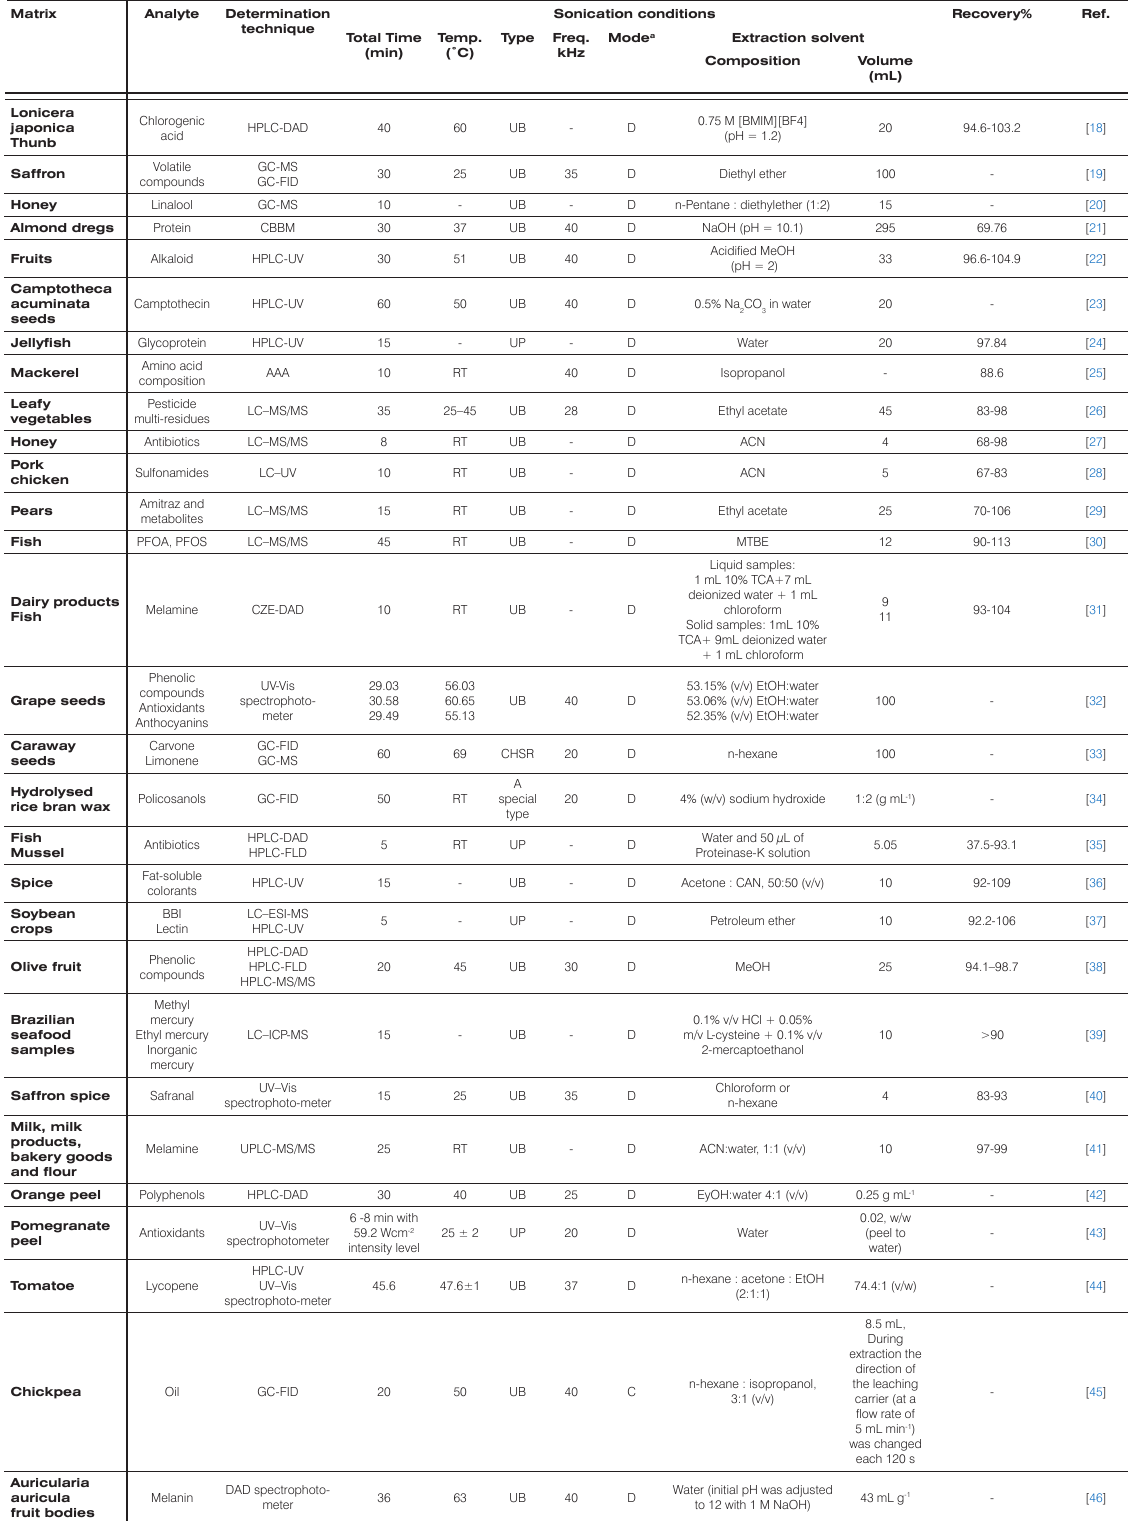
Table 1. Different ultrasound assisted extraction techniques for determination of organic compounds from food samples. Matrix